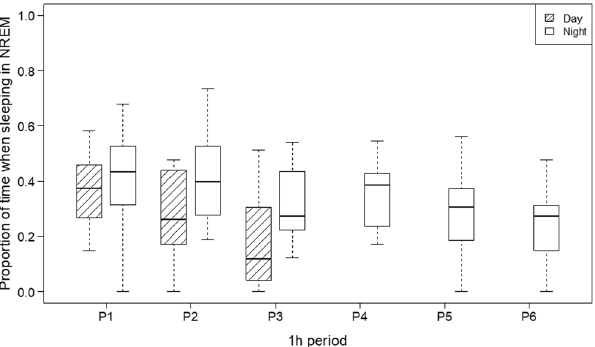
Figure 2. The effects of period and daytime on proportion of sleeping time in NREM: Dogs spent more time in NREM at nighttime and time in NREM decreases over time, both during daytime and during nighttime sleep.